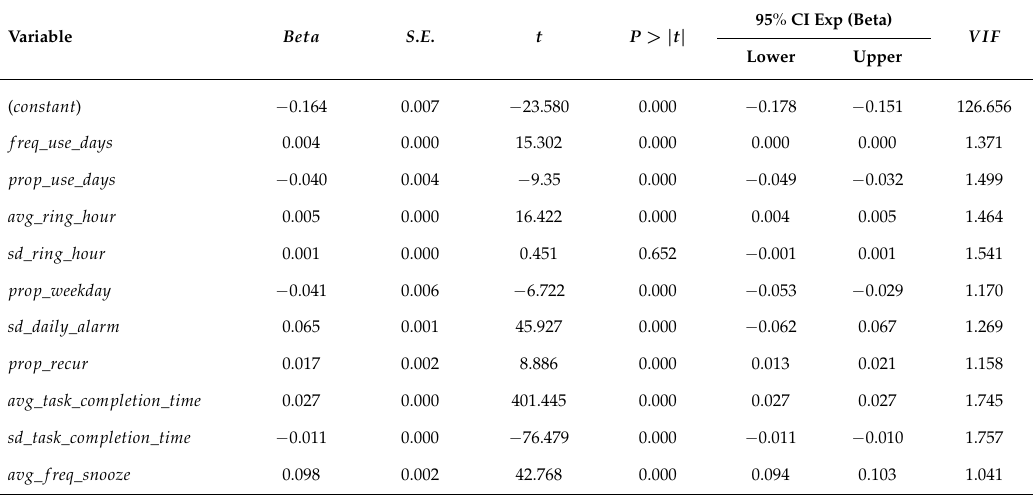
Table 4. Multiple linear regression for identifying